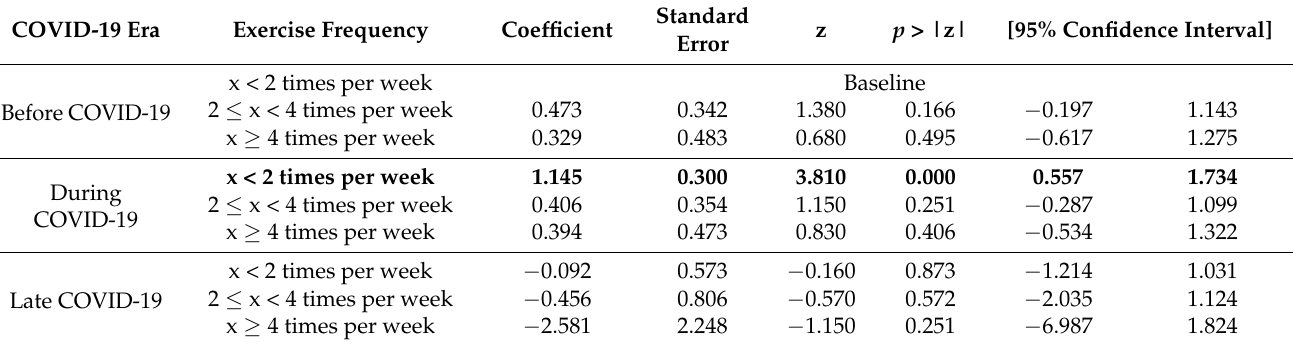
Table 6. The effect of the COVID-19 era and physical exercise frequency on mental distress dur- ing weekends.